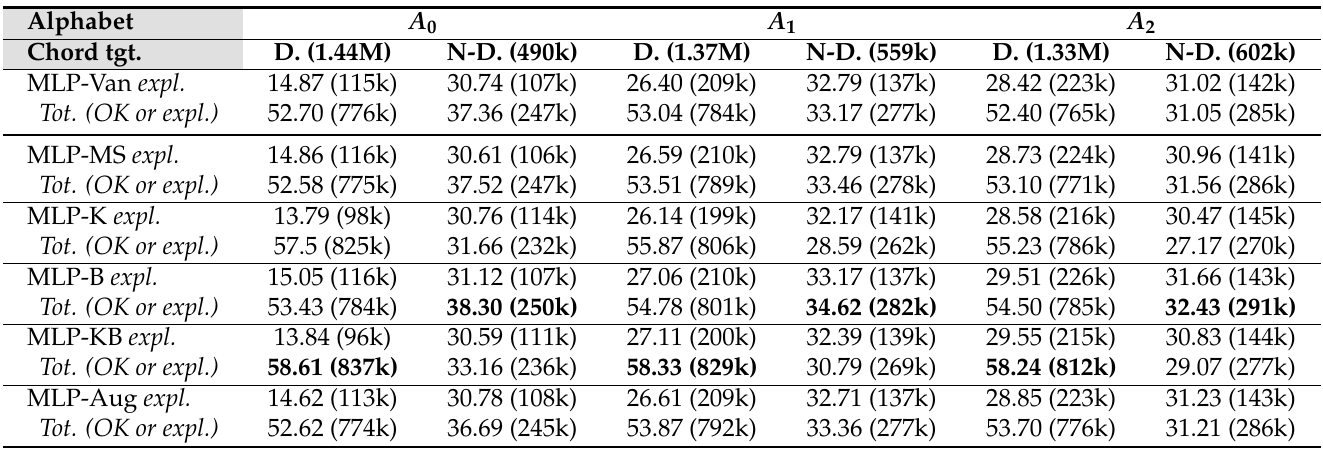
Table A1. For each model: the first line corresponds to the percentage of errors explained by substitution on diatonic (D.) and non-diatonic (N-D.) chord targets, the second line is the total percentage of correct prediction and explainable errors. The amounts of associated items in the test dataset are in